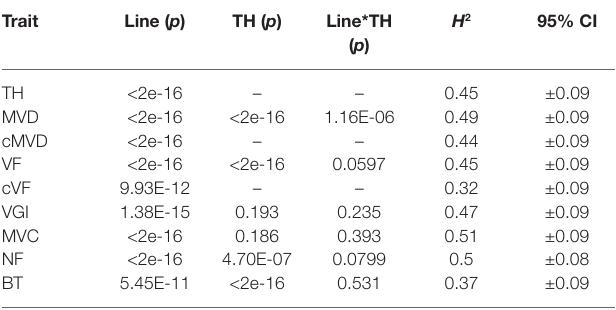
TABLE 3 | ANOVA test results and broad-sense heritabilities ( H 2 ) of phenotypic traits in a 201 genotype